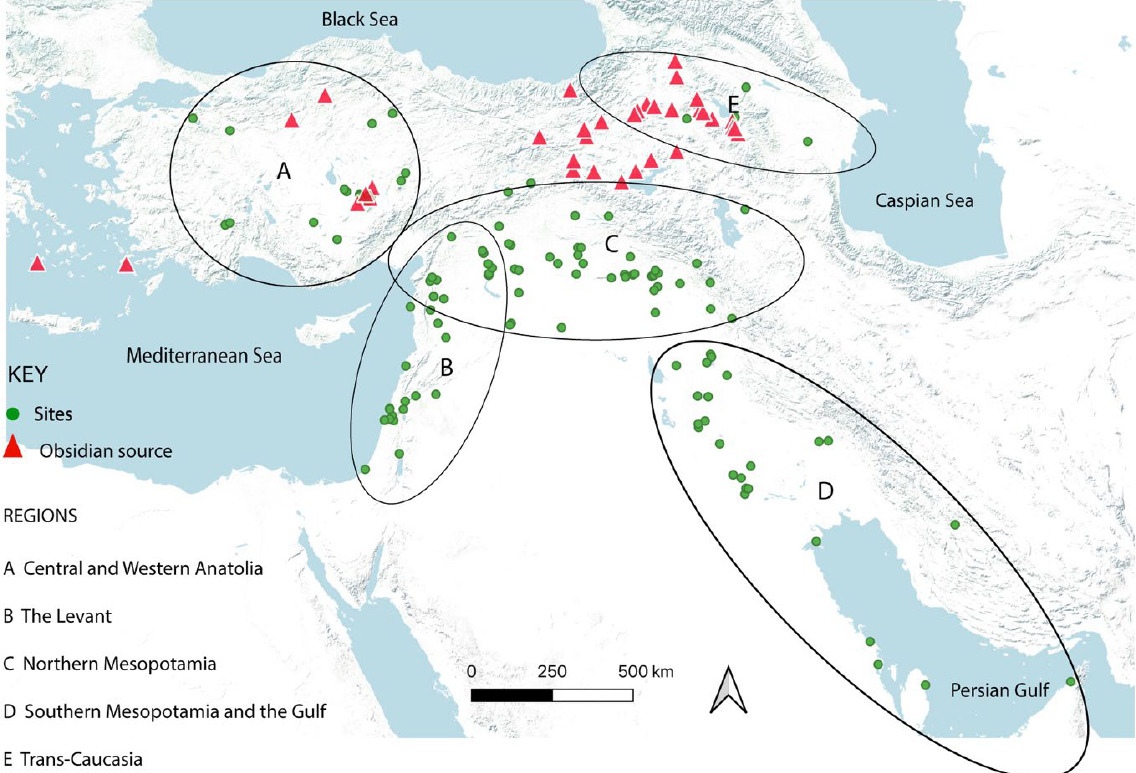
Figure 1. Map showing the location of the sites with non-tool objects and their location in relation to the obsidian